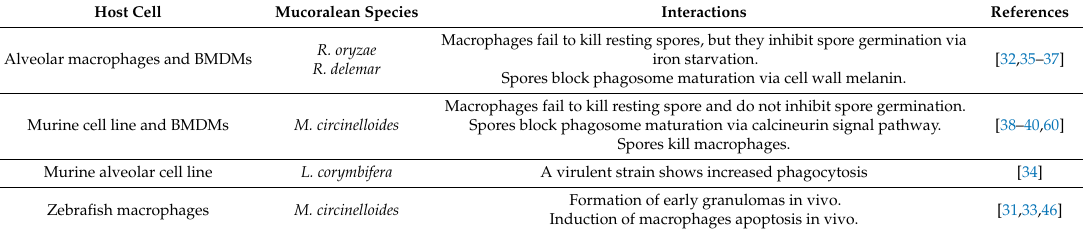
Table 1. Results of the interactions between macrophages and mucoralean